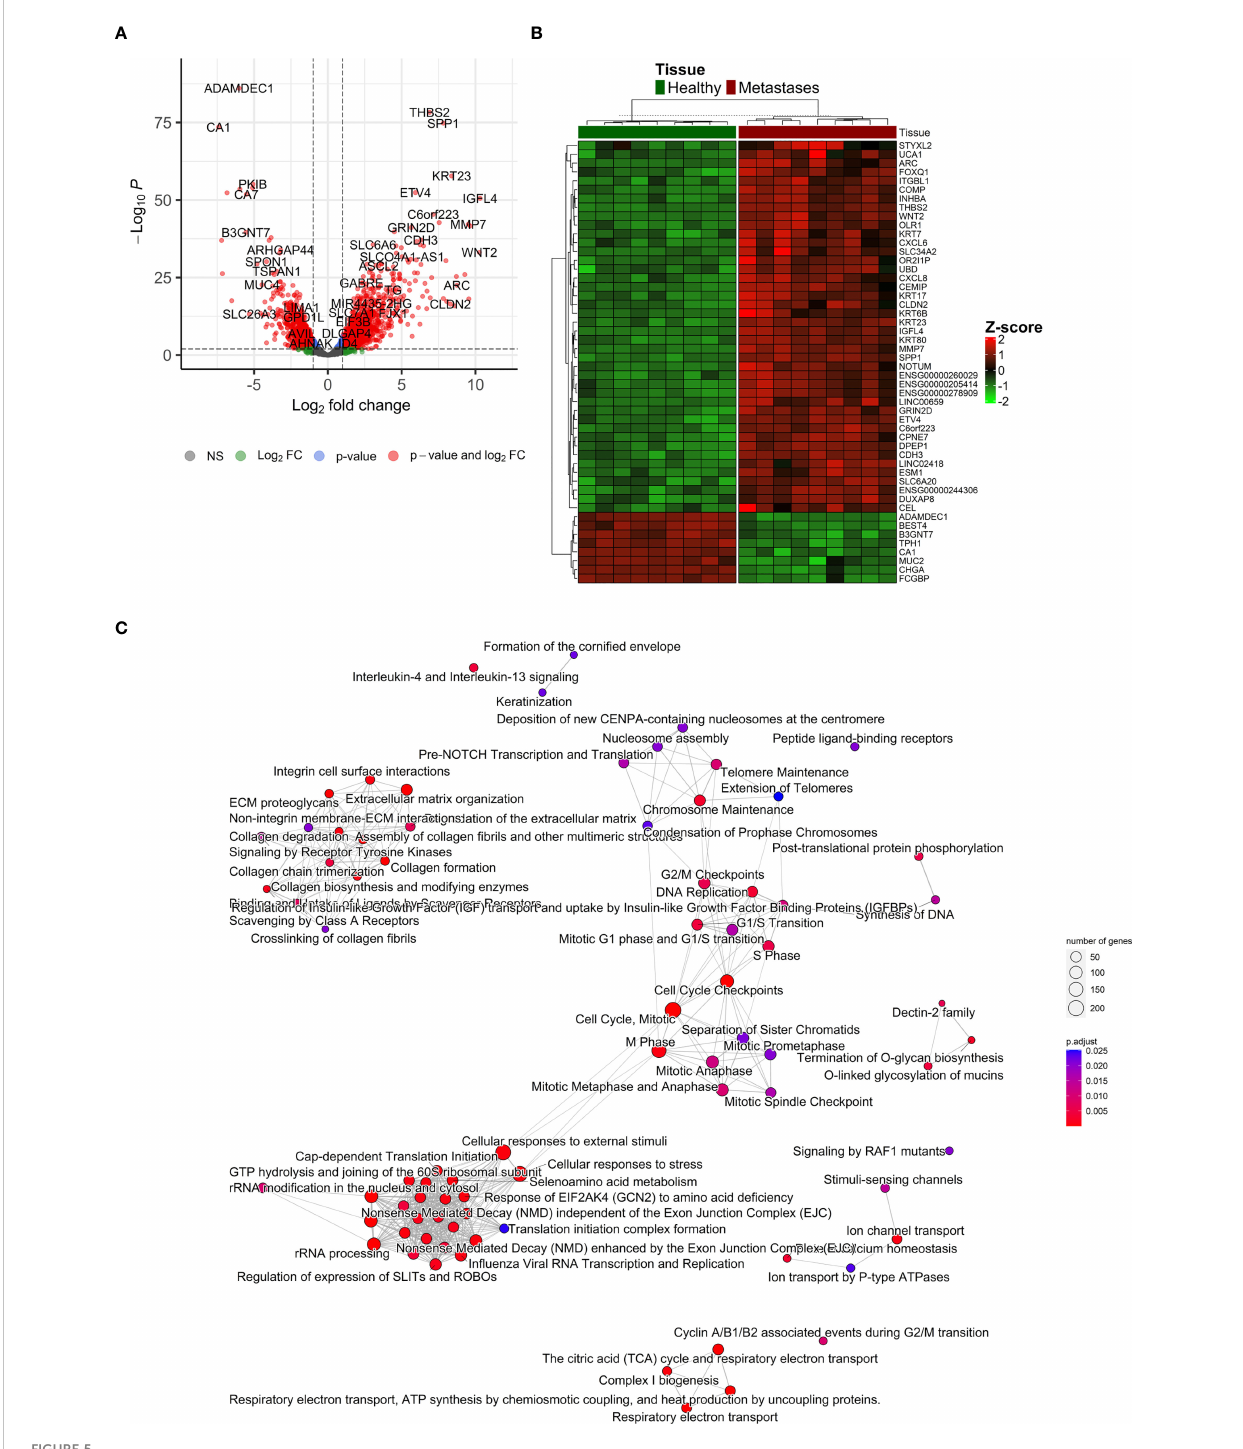
FIGURE 5 Differentially expressed genes ‘ characterization. (A) Volcano plot reporting the log2FC and the adjusted p-value in the DE analysis between metastasis and adjacent liver tissue. Thresholds: adjusted p-value < 0.01 and |log2FC| > 1. (B) Heatmap of top 50 differentially expressed genes between metastasis and control colon tissue. (C) Emapplot of the gene set enrichment analysis (GSEA) of the signi fi cantly deregulated pathways in the Reactome terms (adj. p-value < 0.05, top 80